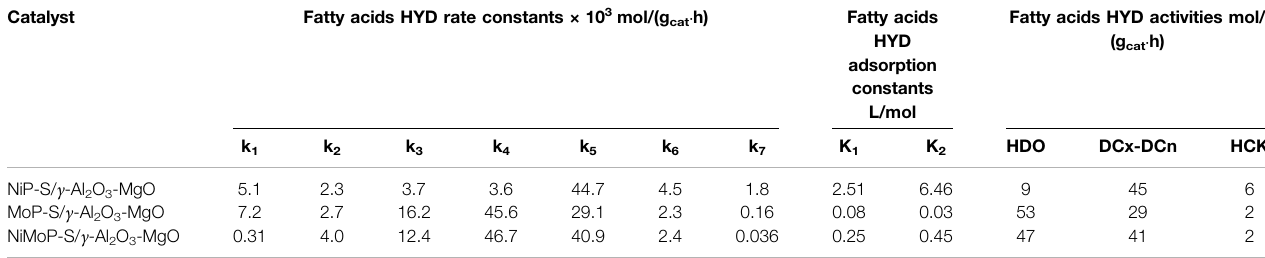
TABLE 4 | Apparent rate constants and adsorption constants of the Al 2 O 3 -MgO supported NiMo mixed phosphidic-sulphidic phase for oleic and stearic acids hydrogenation in the reaction network shown in Scheme 1 .